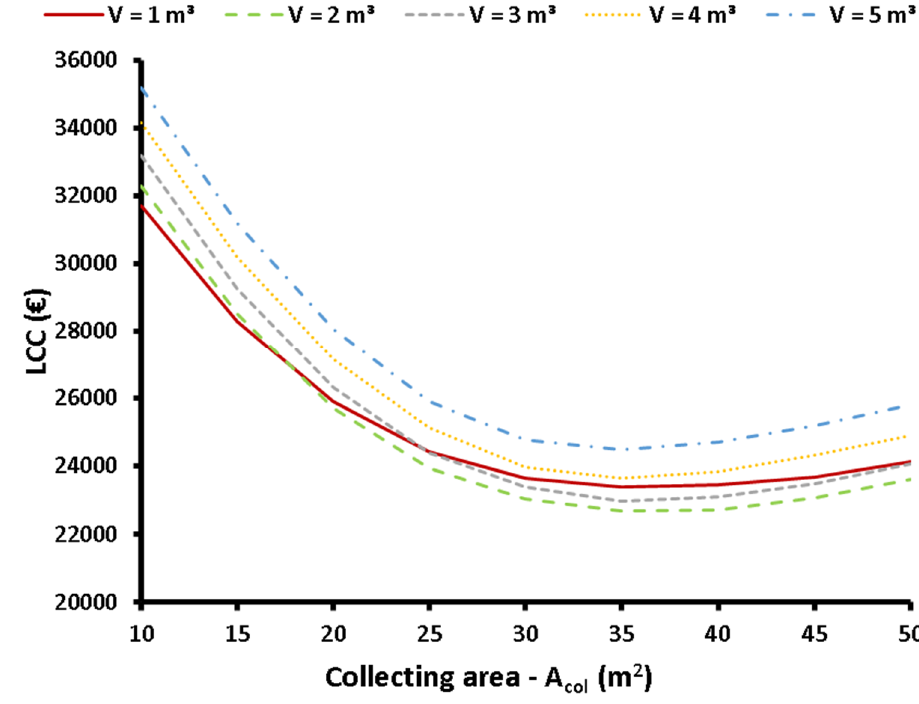
Figure 15. Life cycle cost of the heating system for different combinations of (A col ) and (V).